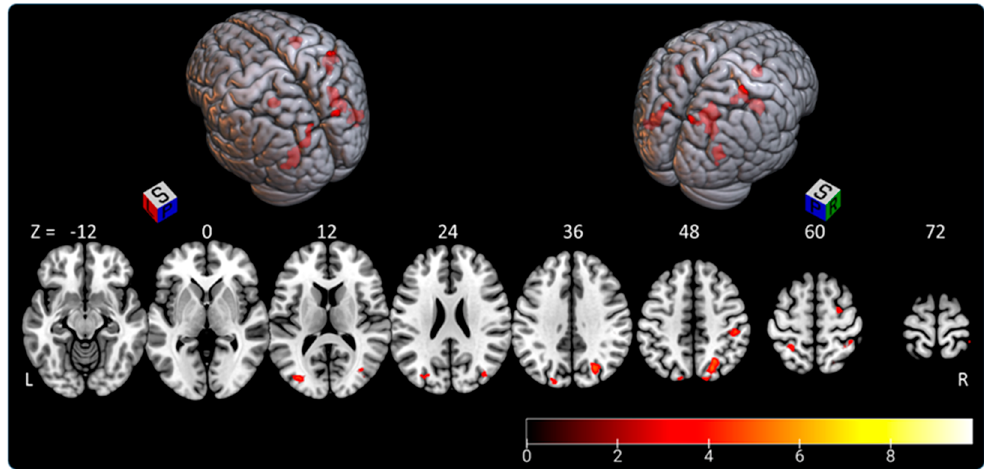
Figure 3. Rendered image of activated clusters highlighted by the “SSA > control condition” contrast. The color bar indicates t ‐ values (BOLD); L—left, P—posterior, R—right, S—superior, Z coordinates in MNI atlas. Table 1. Activated areas highlighted by the “SSA > control condition” contrast. The number of voxels is given for each cluster, together with the side (i.e., left or right hemisphere), the cluster composition (i.e., percentage of voxels in each area assigned using AAL3 and brainnetome atlas), MNI coordinates and t value of the peak. Only activated areas covering more than 10% of the cluster are shown.